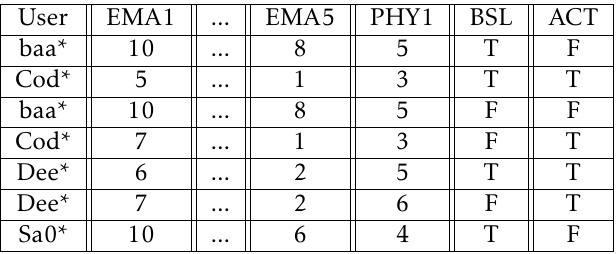
Table 1. Structured EMA and Physiological